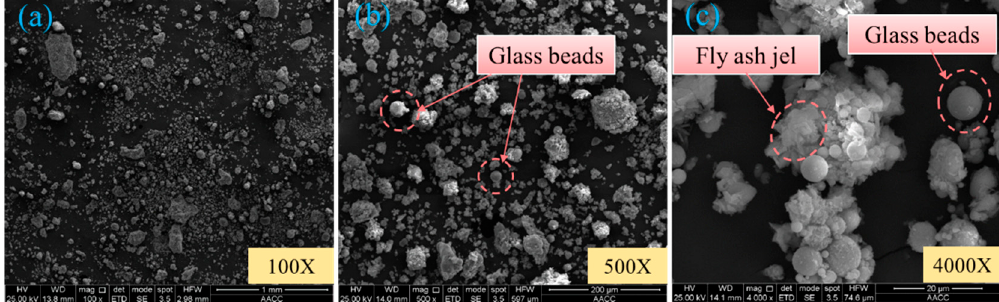
Figure 4. SEM micrographs of FA. Magnification levels are shown in the bottom right-hand corners: ( a ) FA at 100x magnification; ( b ) FA at 500x magnification; ( c ) FA at 4000x magnification.